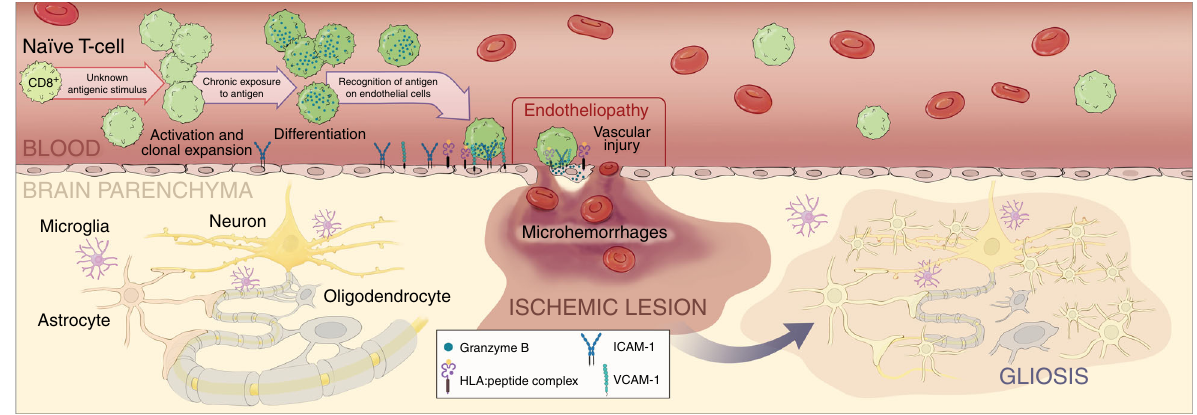
Fig. 8 Role of CD8 + T cells in the pathophysiology of SuS. Working model of role of CD8 + T cells in the pathophysiology of SuS. A yet unknown antigenic stimulus drives activation, clonal expansion, and differentiation of CD8 + T cells into GrB- and perforin-expressing CD8 + T EMRA cells. CD8 + T cells accumulate in microvessels of the brain, retina, and inner ear, where they adhere to the endothelium, recognize HLA:peptide complex(es), polarize their cytolytic vesicles toward the endothelial plasma cell membrane, and induce apoptosis of ECs, most likely in a perforin/GrB-dependent manner. Death of ECs and focal disruption of the blood – brain barrier result in microhemorrhages, whereas occlusion of small blood vessels leads to small ischemic lesions with loss of astrocytes, oligodendrocytes, neurons, and axons. Finally, ischemic lesions become gliotic by in fi ltration of surrounding